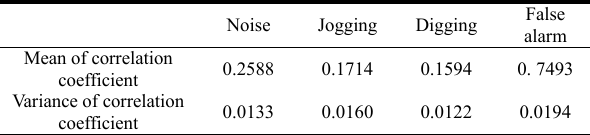
Table 4: Analysis on four types of